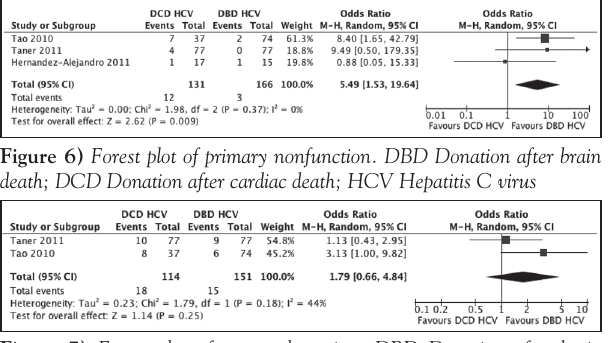
Figure 7) Forest plot of retransplantation. DBD Donation after brain death; DCD Donation after cardiac death; HCV Hepatitis C virus